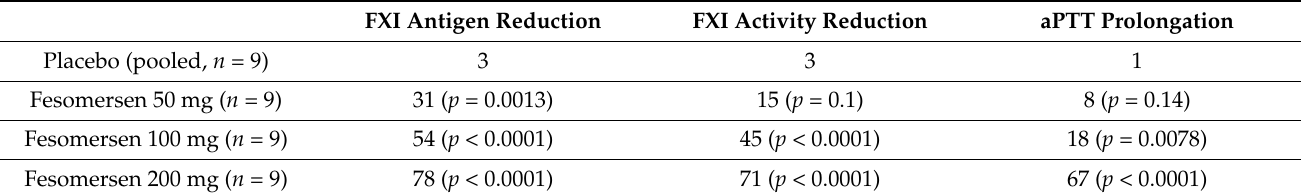
Table 10. Mean (%) change from baseline in the multiple ascending dose regimen of fesomersen. Data are from Liu, Q. et al.